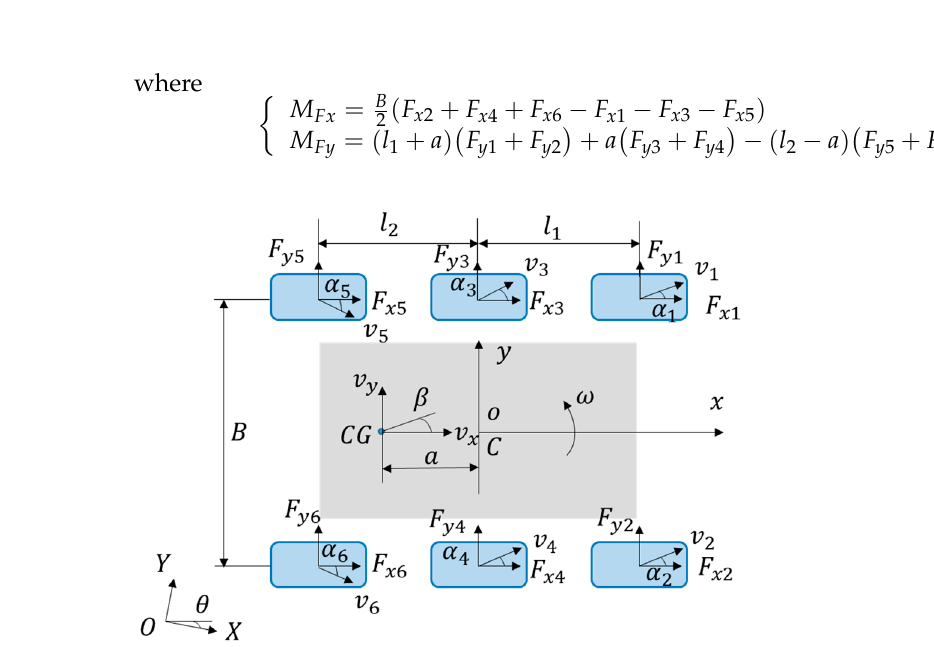
Figure 1. Schematic diagram of the vehicle dynamics model.